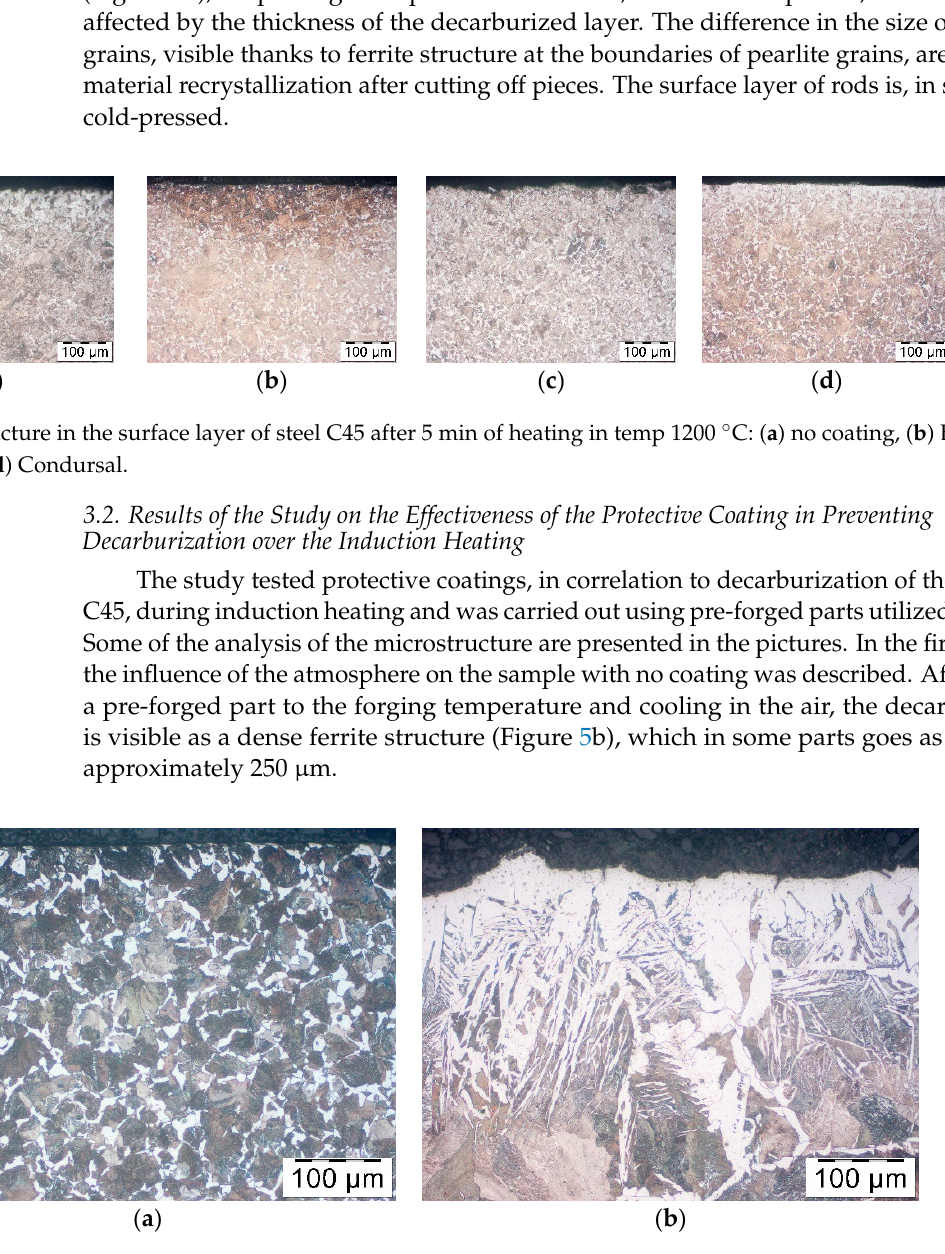
Figure 5. Microstructure of the surface layer of the steel bar C45: ( a ) when delivered and ( b ) after heated for forging and cooling in the air.